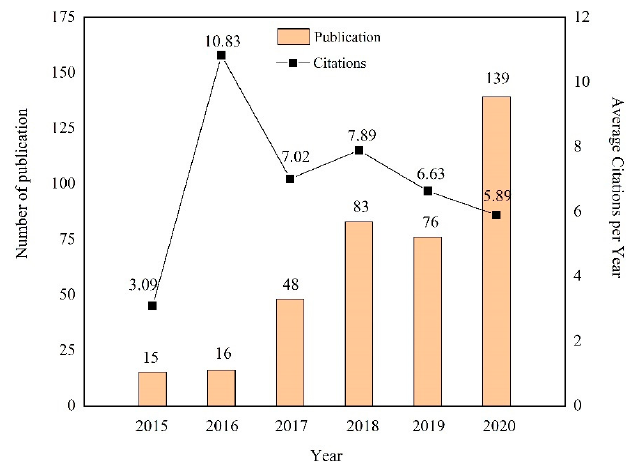
Figure 4. The number of publications and times cited per year in 2015–2020.